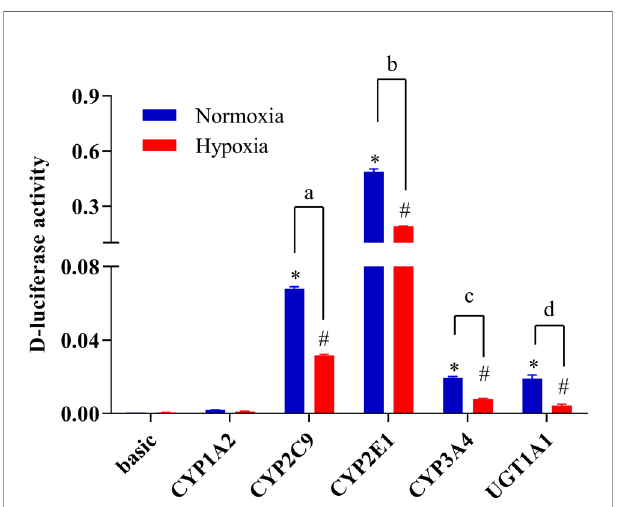
FIGURE 9 | The promoter activity of CYP1A2, CYP2C9, CYP2E1, CYP3A4, and UGT1A1 following treatment with KCZ and RA. HepG2 cells were transfected with pGL3-CYP1A2, pGL3-CYP2C9, pGL3-CYP2E1, pGL3- CYP3A4, pGL3-UGT1A1, or empty vector. The HepG2 cells treatment with KCZ or RA after transfection in normoxia. KCZ (Ketoconazole): PXR inhibitors; RA (Retinoic acid): CAR inhibitors. The data were analyzed using a one-way analysis of variance (ANOVA), and the differences between the means of two groups were compared using LSD tests. *,#,**,## indicates the signi fi cance of each of the experimental groups compared with that of the control. * p < 0.05 vs. DMSO-CYP2C9; # p < 0.05 vs. DMSO-CYP2E1; ** p < 0.05 vs. DMSO- CYP3A4; ## p < 0.05 vs. DMSO-UGT1A1. Values were expressed as Mean ± SEM (n = 3). Levels are considered signi fi cant at * p < 0.05, # p < 0.05, ** p < 0.05, ## p <